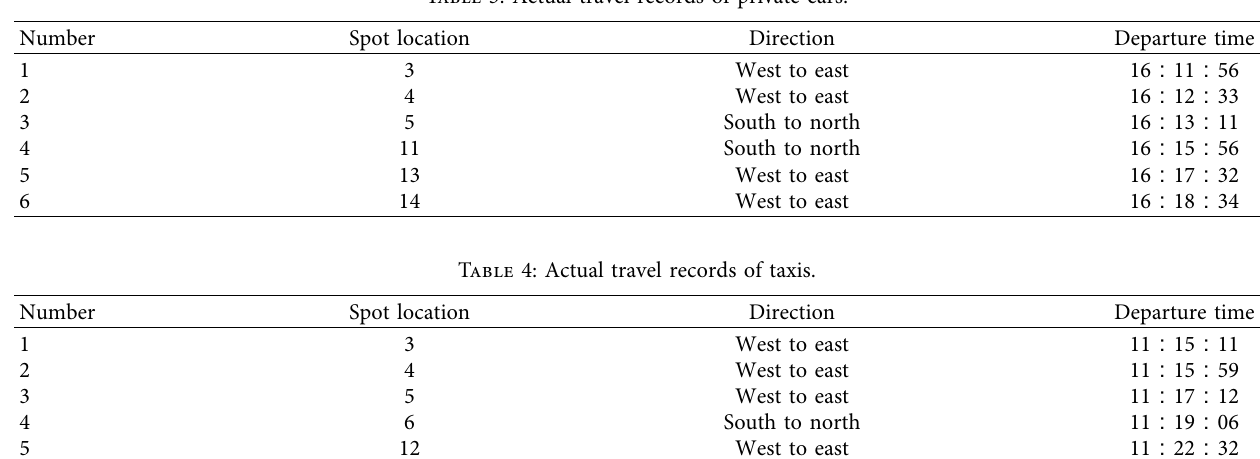
Figure 4: Diagram of the actual travel path of private cars and taxis. Table 3: Actual travel records of private cars.